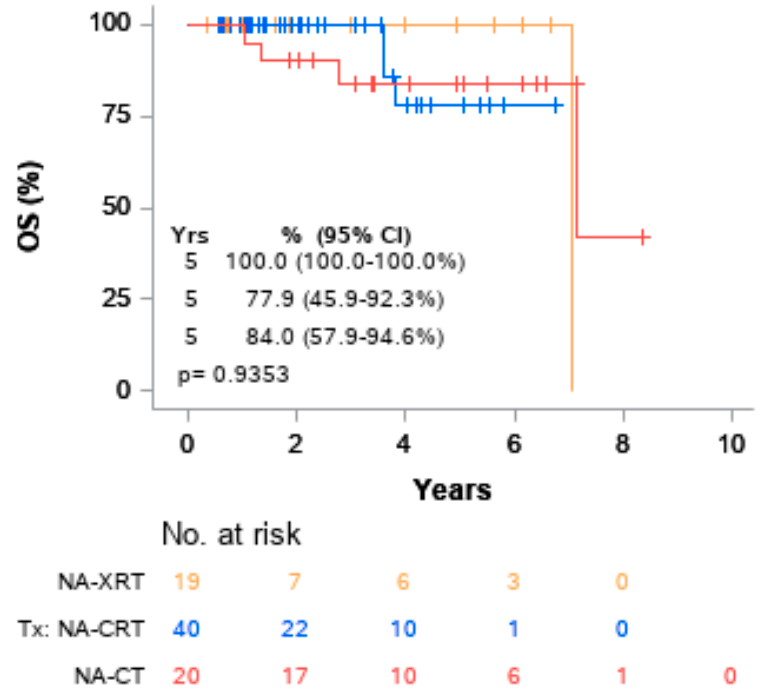
Figure 3. Kaplan–Meier curves of OS by treatment type.